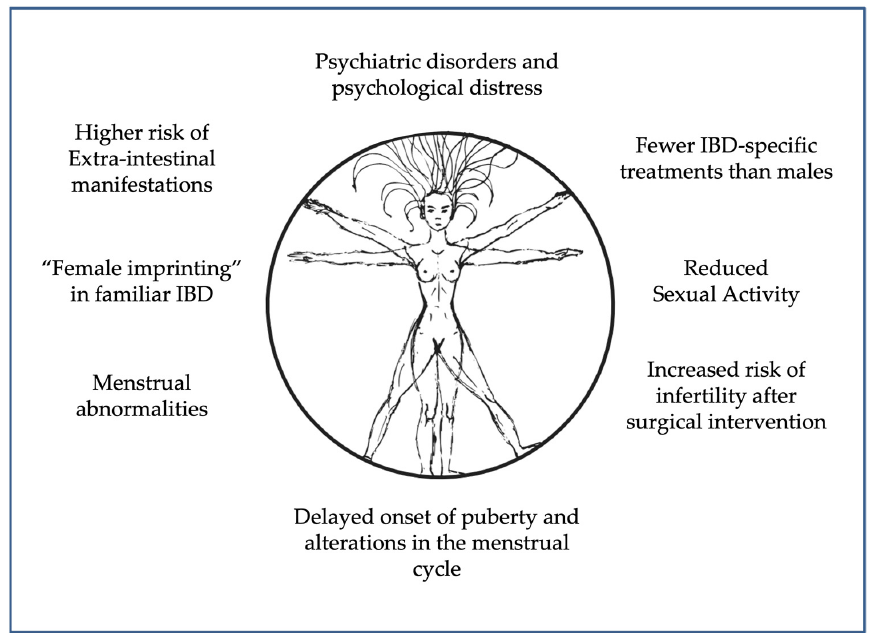
Figure 2. Summary scheme detailing various IBD-related abnormalities known to affect women’s health .